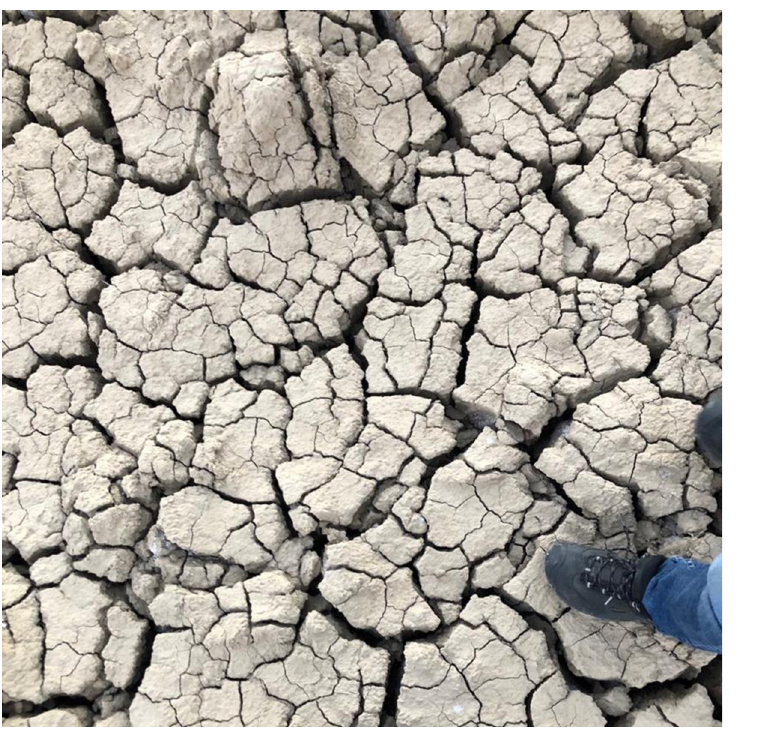
Fig 4. Hard and thick surface crusts on soil